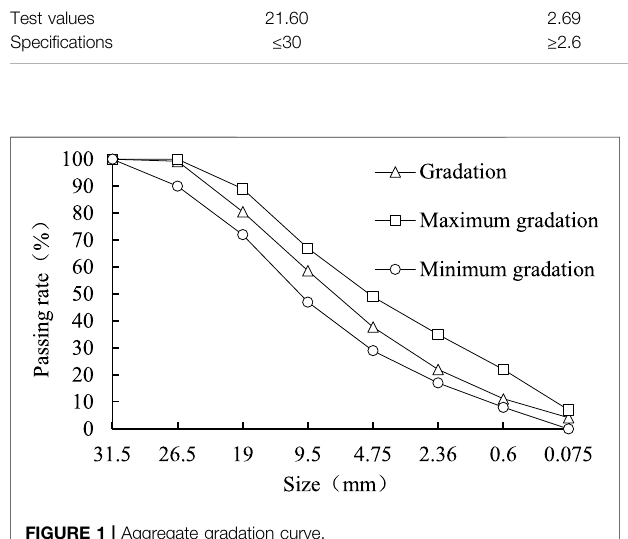
FIGURE 1 | Aggregate gradation curve.